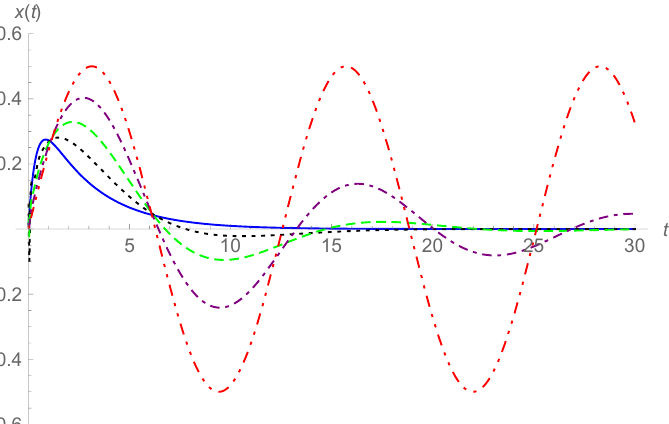
Figure 8. Curves of x ( t ) for m = k = 1, c = 3, and for α = 1 (solid line), α = 1.25 (dotted line), 1.5 (dashed line), 1.75 (dotted-dashed line), and 2 (dotted-dotted-dashed line).